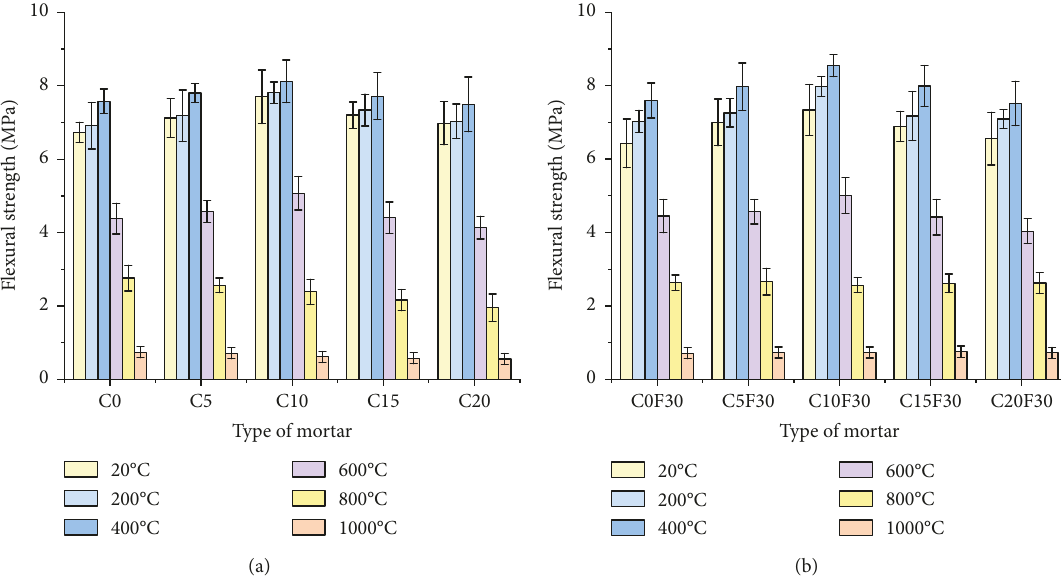
Figure 4: Flexural strength of (a) CaCO 3 whisker-based specimens and (b) CaCO 3 whisker-based fly ash specimens before and after exposure to various temperatures.